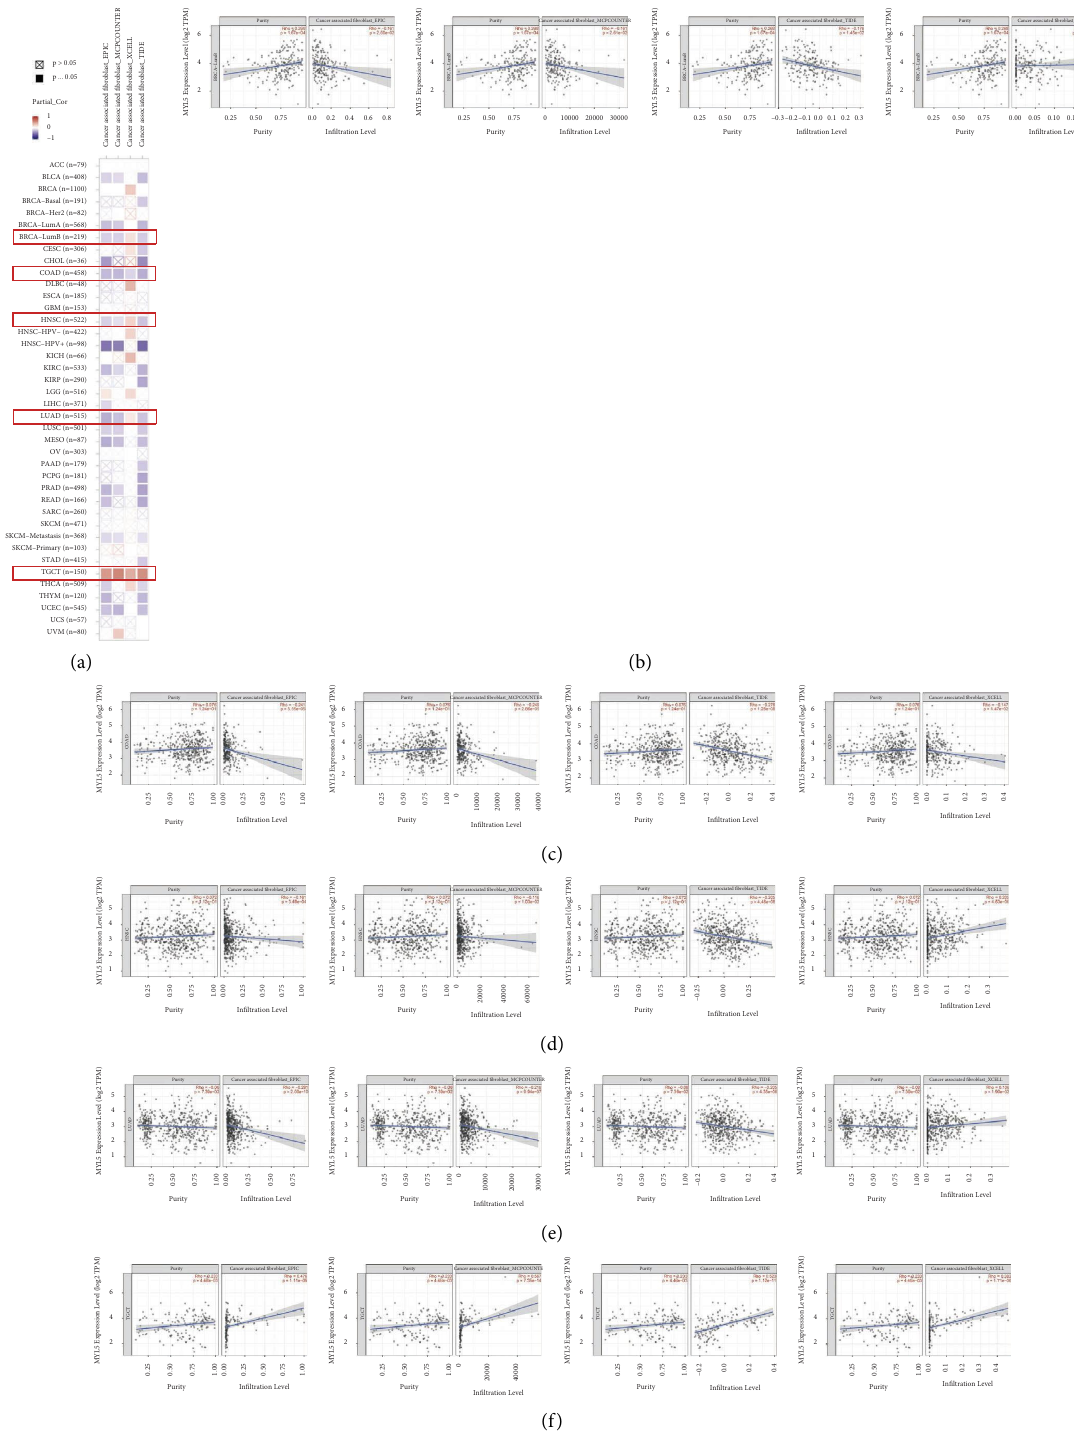
Figure 4: Correlation analysis between MYL5 expression and immune infltration of cancer associated fbroblasts by using the TIMER2.0 tool. Diferent algorithms were used to explore the potential correlation between the expression level of the MYL5 gene and the infltration level of cancer-associated fbroblasts across all types of cancer in TCGA. Te heatmap (a), and the scatter plot of BRCA-lumB (b), COAD (c), HNSC (d), LUAD (e), and TGCT (f) in four datasets were given. p value was analyzed by the Spearman’s